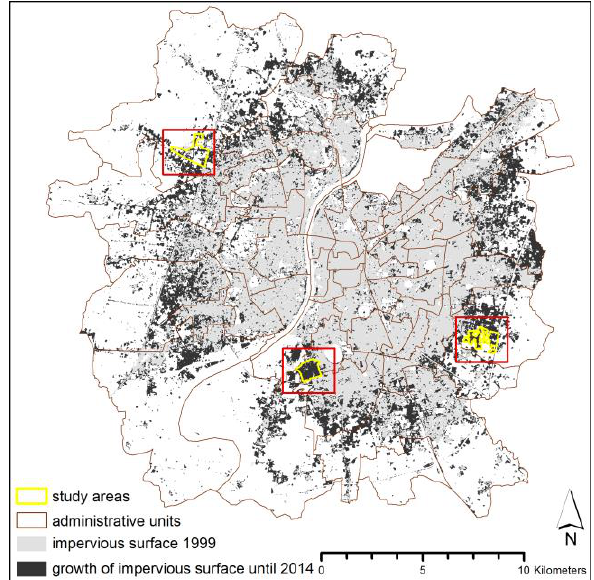
Figure 2: Growth of urban footprint for